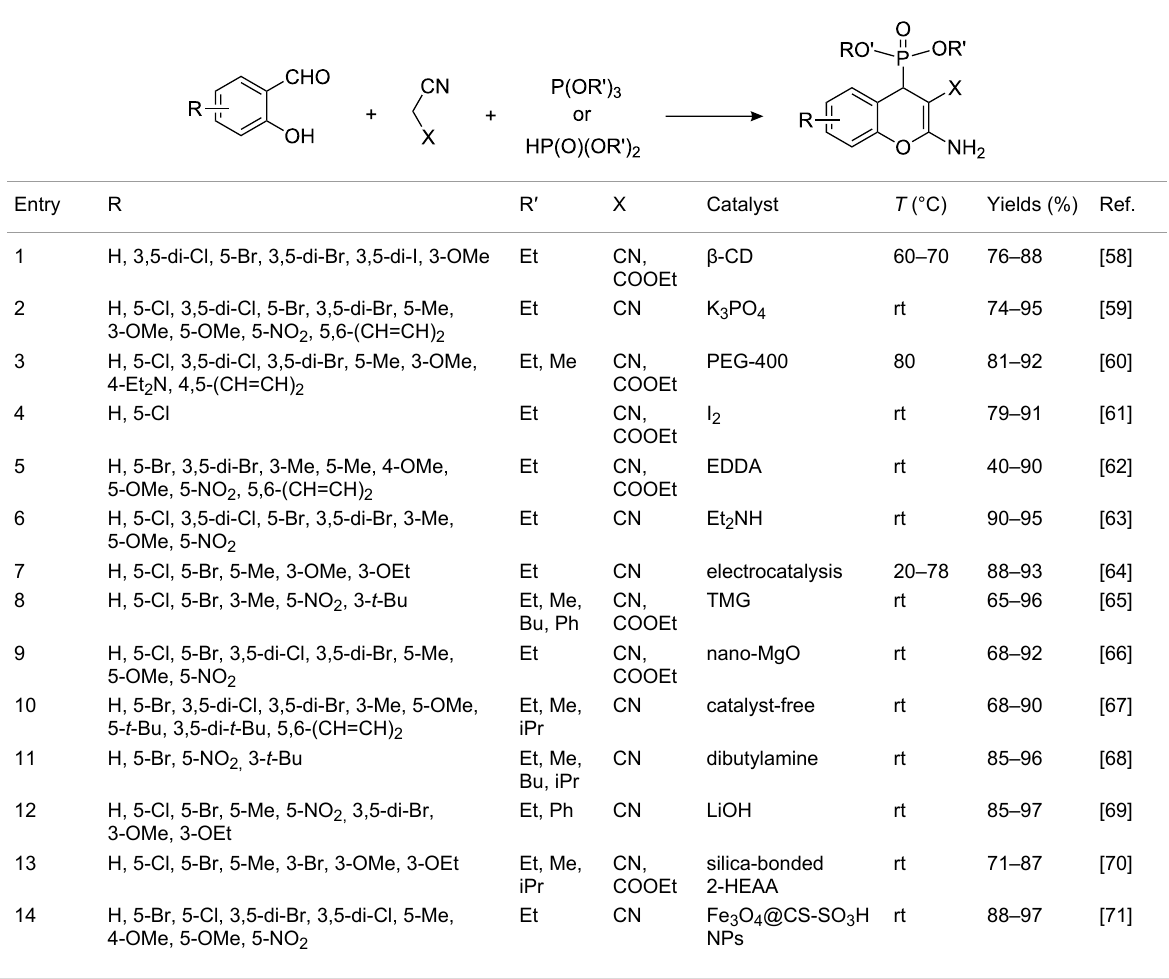
Table 1: Different catalytical methods for the synthesis of 2-amino-3-cyano-4 H